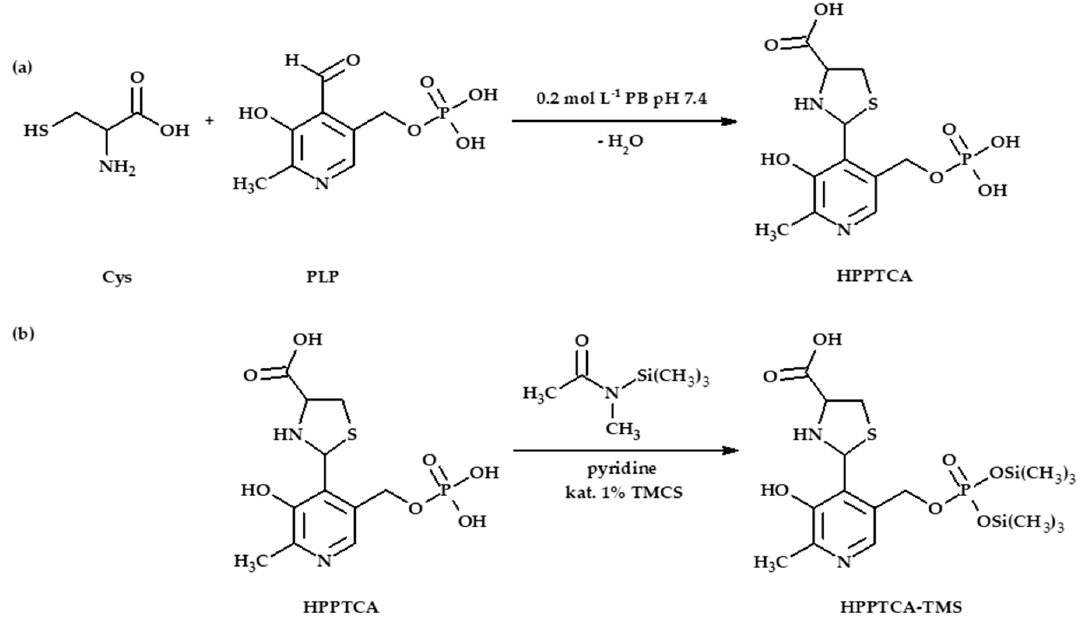
Figure 4. ( a ) The reaction equation of Cys with PLP providing HPPTCA. ( b ) Chemical derivatization reaction of HPPTCA with MSTFA in the presence of TMCS, affording HPPTCA-TMS derivative.